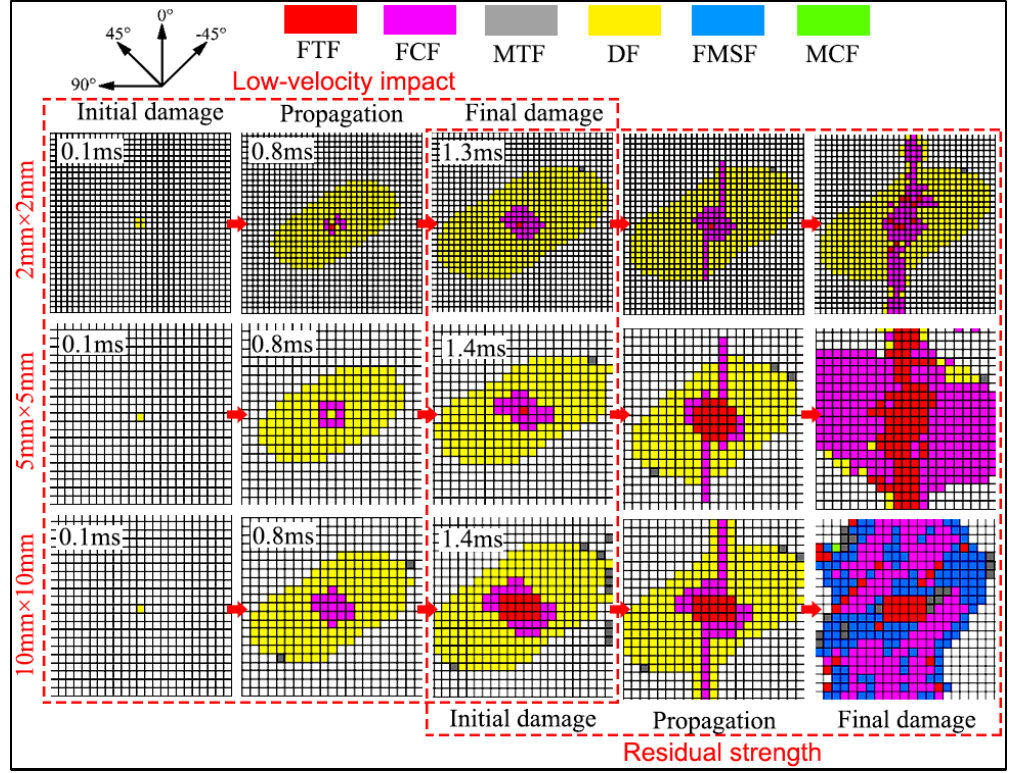
Figure 10. Full-process of low-velocity impact damage and residual strength for laminates with different stitched densities.